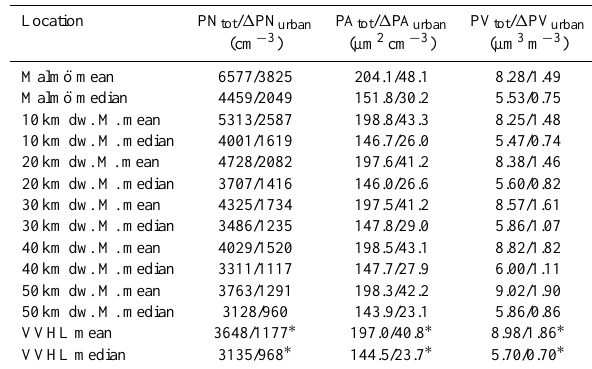
Table 2. Estimated average and median particle number, sur- face area and volume concentration (PN tot , PA tot , and PV tot re- spectively) and its contribution from Malm¨o (difference between the center of the urban plume and the background) ( 1 PN urban , 1 PA urban , and 1 PV urban ) for particles between 5 and 1000nm in diameter in the center of the urban plume, at different distances downwind of Malm¨o (dw.